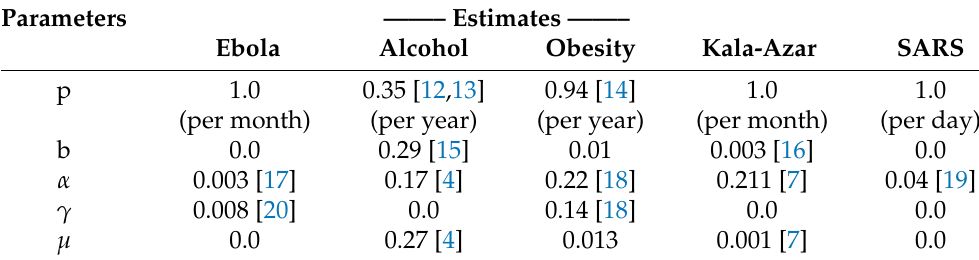
Table 3. Definition of variables and parameters in the model given by Equations (1) and